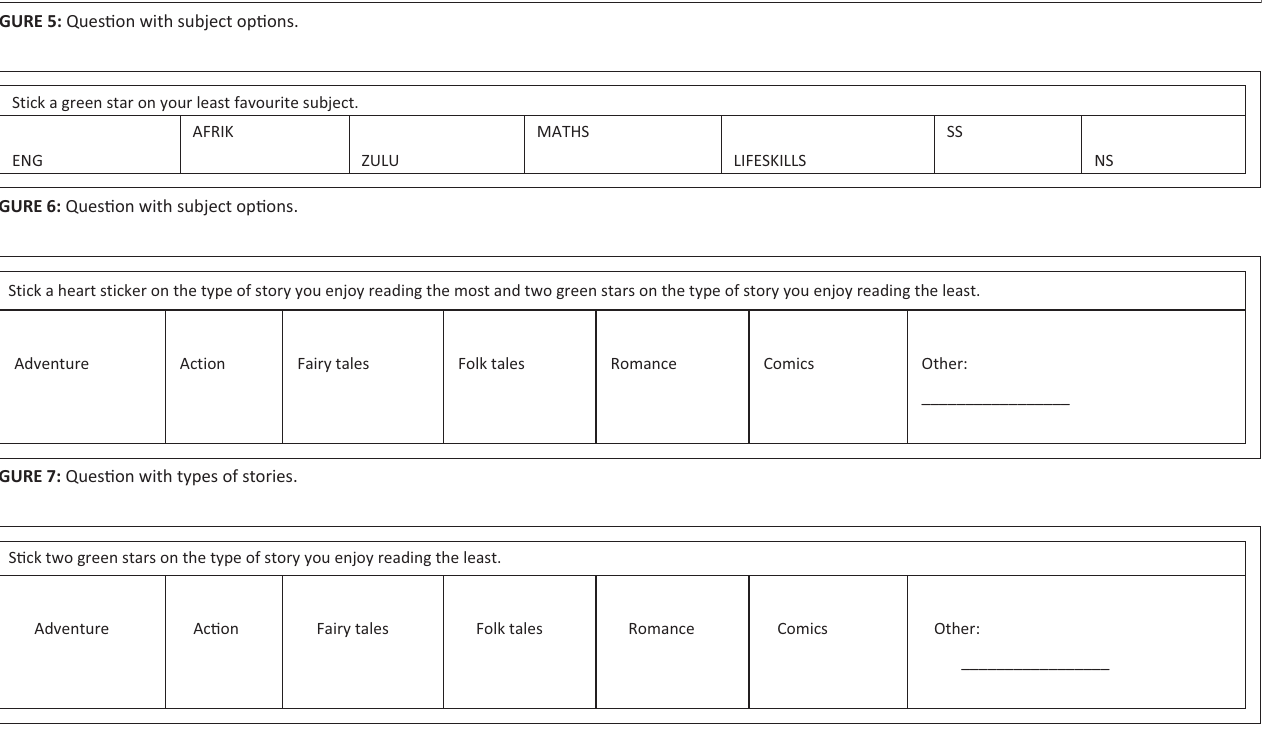
FIGURE 8: Question with types of